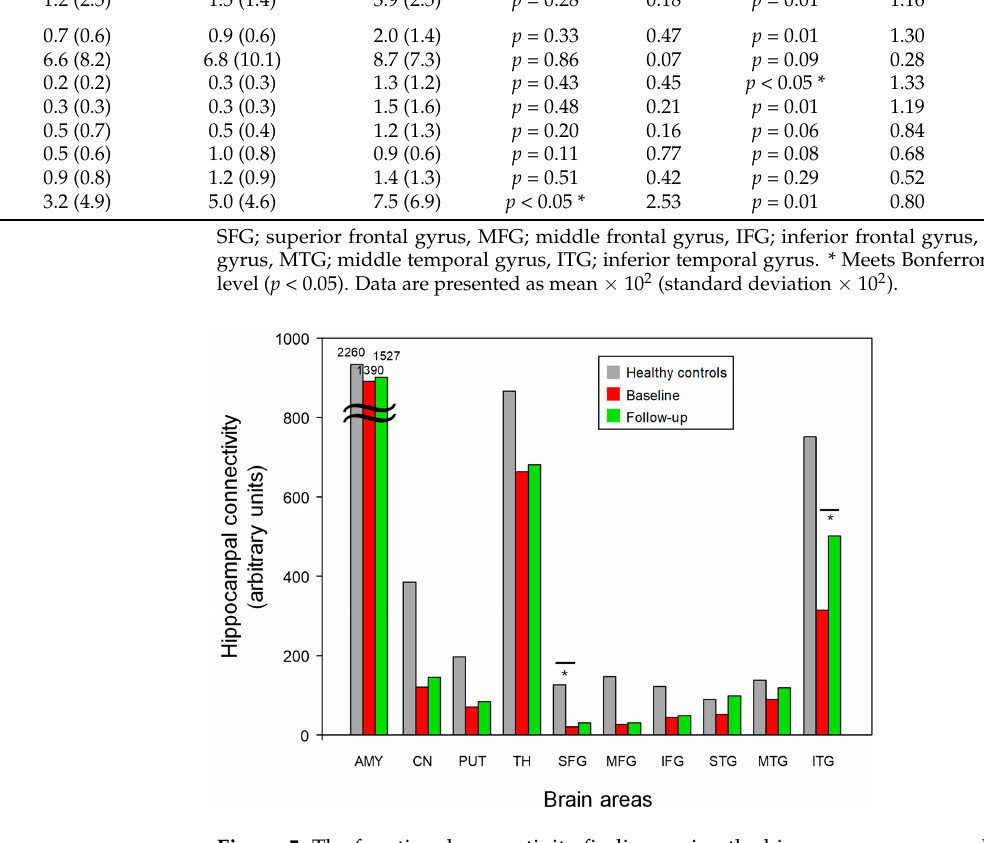
Figure 5. The functional connectivity findings using the hippocampus as a seed region in the patients with early AD (baseline and 6-month follow-up) and the healthy controls. The patients with early AD showed a significant decrease in hippocampal-SFG WM connectivity compared to the healthy controls (Bonferroni-corrected, p < 0.05). Following the 6-month donepezil treatment, the patients with early AD showed increased hippocampal-ITG WM connectivity (Bonferroni-corrected, p < 0.05). AMY; amygdala, CN; caudate nucleus, HIP; hippocampus, PUT; putamen, SFG; superior frontal gyrus, MFG; middle frontal gyrus, IFG; inferior frontal gyrus, STG; superior temporal gyrus, MTG; middle temporal gyrus, ITG; inferior temporal gyrus. * Meets Bonferroni-corrected significance level ( p < 0.05).